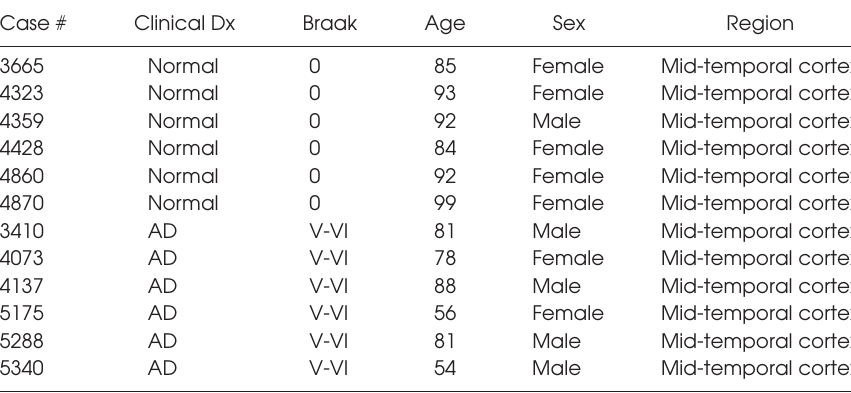
table 1. Human cases analyzed in this